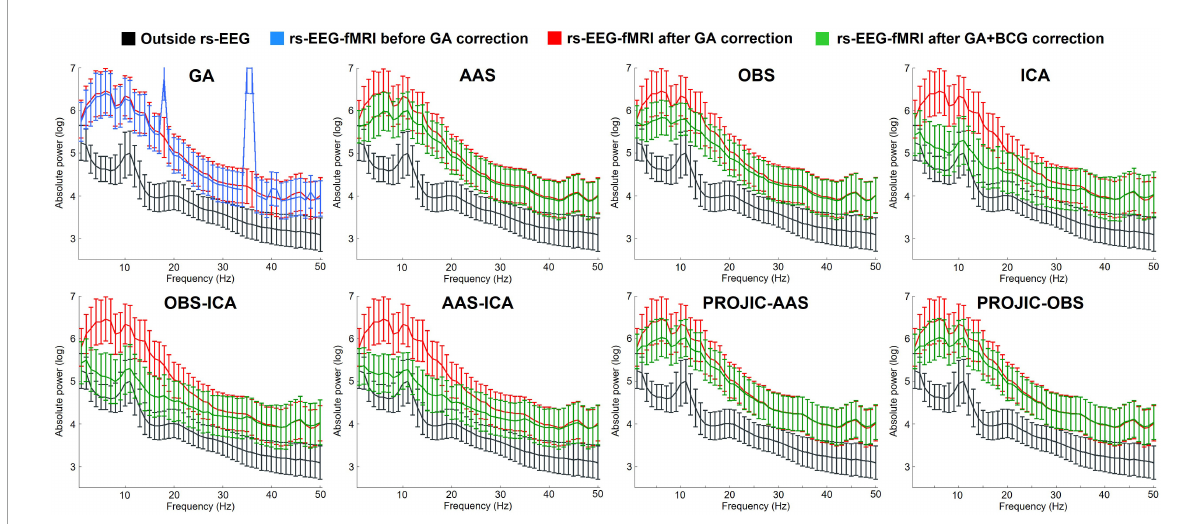
FIGURE1 Average power spectrum (and standard deviation) computed from the resting-state eyes-closed EEG signal of all electrodes from all subjects. The first panel shows the Outside rs-EEG (black) and the rs-EEG-fMRI data before (blue) and after (red) GA correction. The rest of the panels show a comparison between the Outside rs-EEG (black line, repeated in all panels), the rs-EEG-fMRI after GA removal but before BCG artifact correction (red line, repeated in all panels) and its corrected version (green) after using one of seven BCG correction methods: Average Artifact Subtraction (AAS), Optimal Basis Set (OBS), Independent Component Analysis (ICA), OBS-ICA, AAS-ICA, PROJection onto Independent Components (PROJIC)-AAS or PROJIC-OBS. ICA-based corrections performed better in reducing the BCG artifact contribution and preserving the spectral profile of rs-EEG-fMRI signals, though power remained higher compared to the Outside